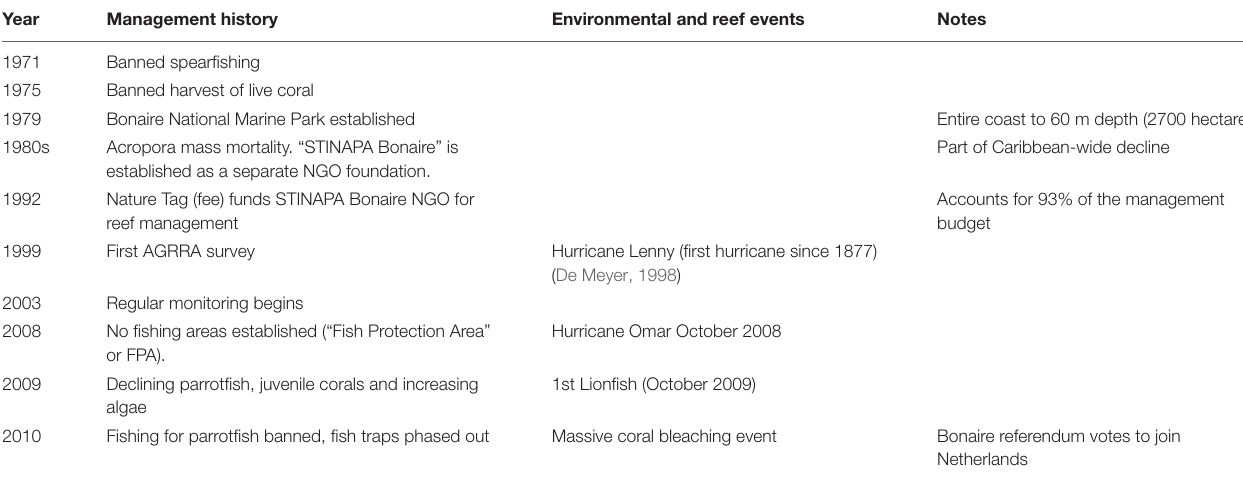
TABLE 1 | Summary timeline of Bonaire’s coral reef management actions and environmental